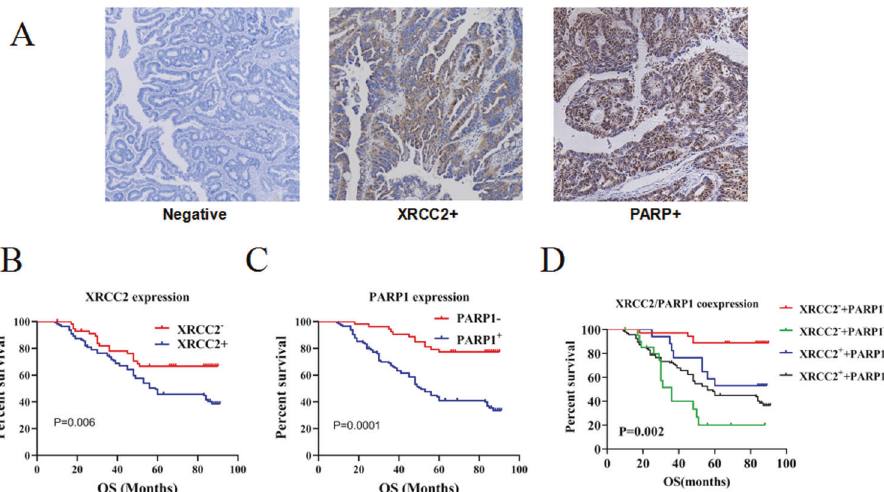
Fig. 1 Prognostic signi fi cance of XRCC2 and PARP1 expression in LARC patients who received neoRT. A Representative immunohistochemical images showing the expression of XRCC2 and PARP1 in rectal tissues (×200). B Kaplan – Meier analysis of the effect of XRCC2 expression on OS. C Kaplan – Meier analysis of the effect of PARP1 expression on OS. D Kaplan – Meier analysis of the effect of XRCC2/ PARP1 co-expression on